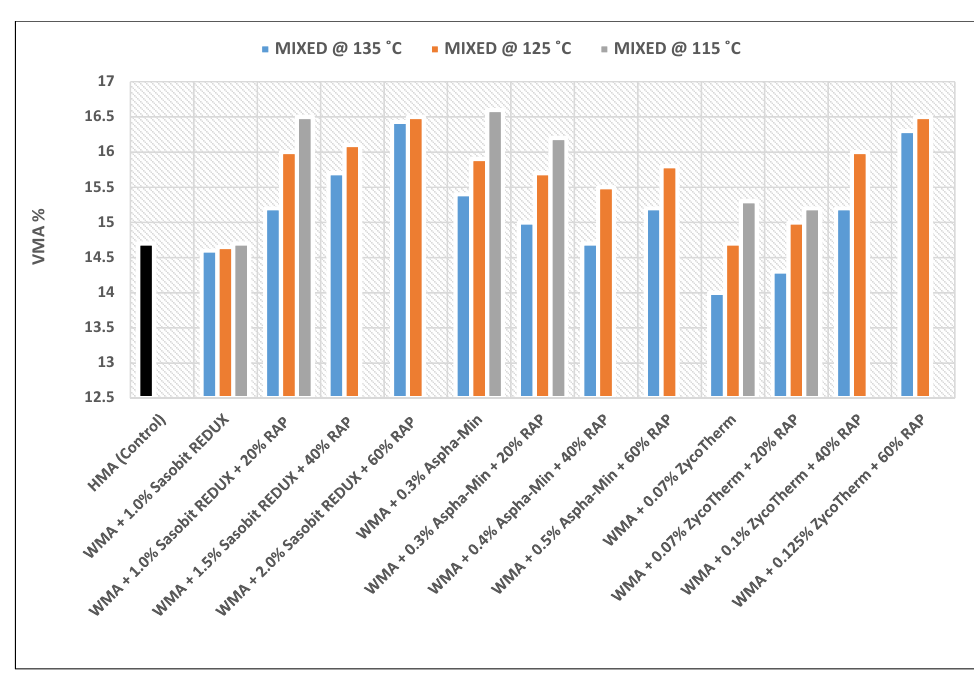
Figure 19. VMA% for the modified virgin and recycled WMA mixtures.